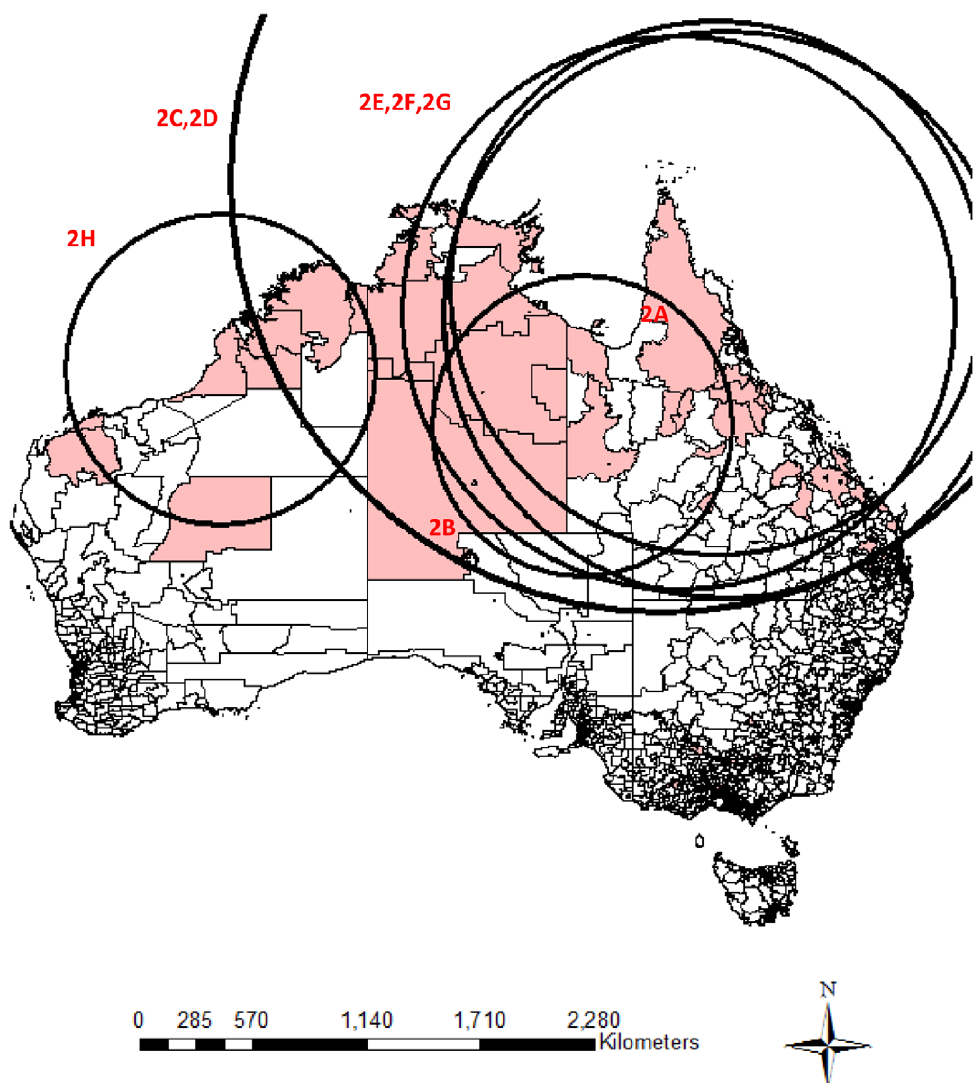
Figure 2. Significant clusters identified by national cluster detection with 2 month maximum temporal cluster size. Remark: Shaded regions are postal areas with completed suicide incidents within the particular clustering period. Circles represent the significant clustering windows detected by scan statistics.